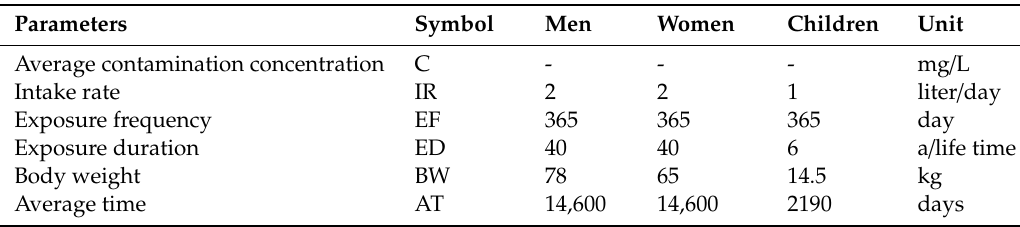
Table 2. Input parameters of the risk